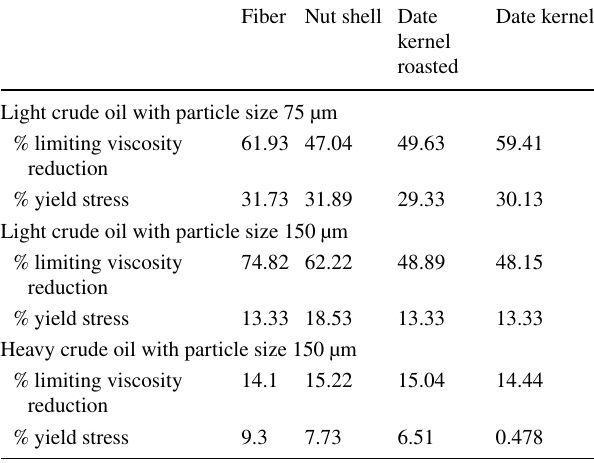
Table 1 Summary of